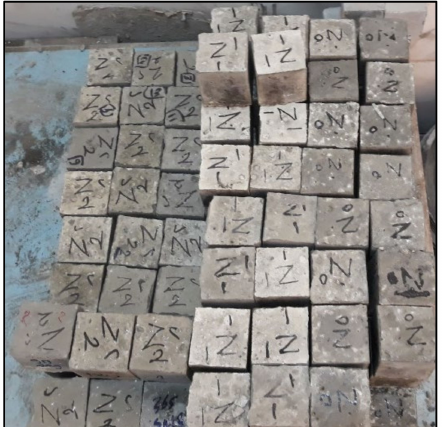
Figure 8. Group Z